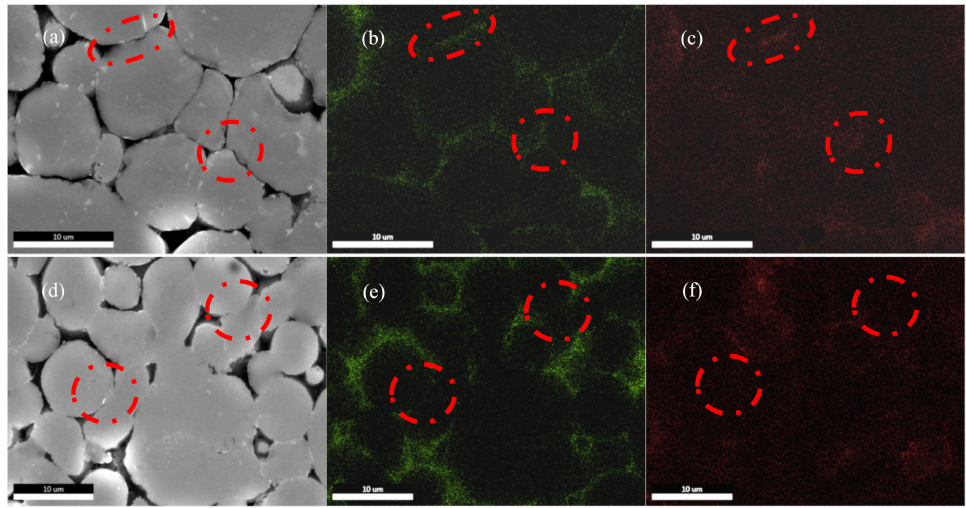
Figure 12. EDS Mapping of sintered specimens. ( a ) 580 ◦ C, 100 min. ( b ) O. ( c ) Mg. ( d ) 620 ◦ C, 100 min. ( e ) O. ( f )